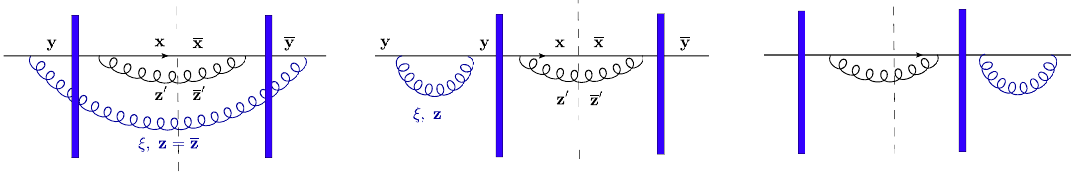
Figure 23 . The set of “real” and “virtual” graphs which count for the cancellation of the overlap- ping, soft and collinear, divergences associated with the first gluon emission by the